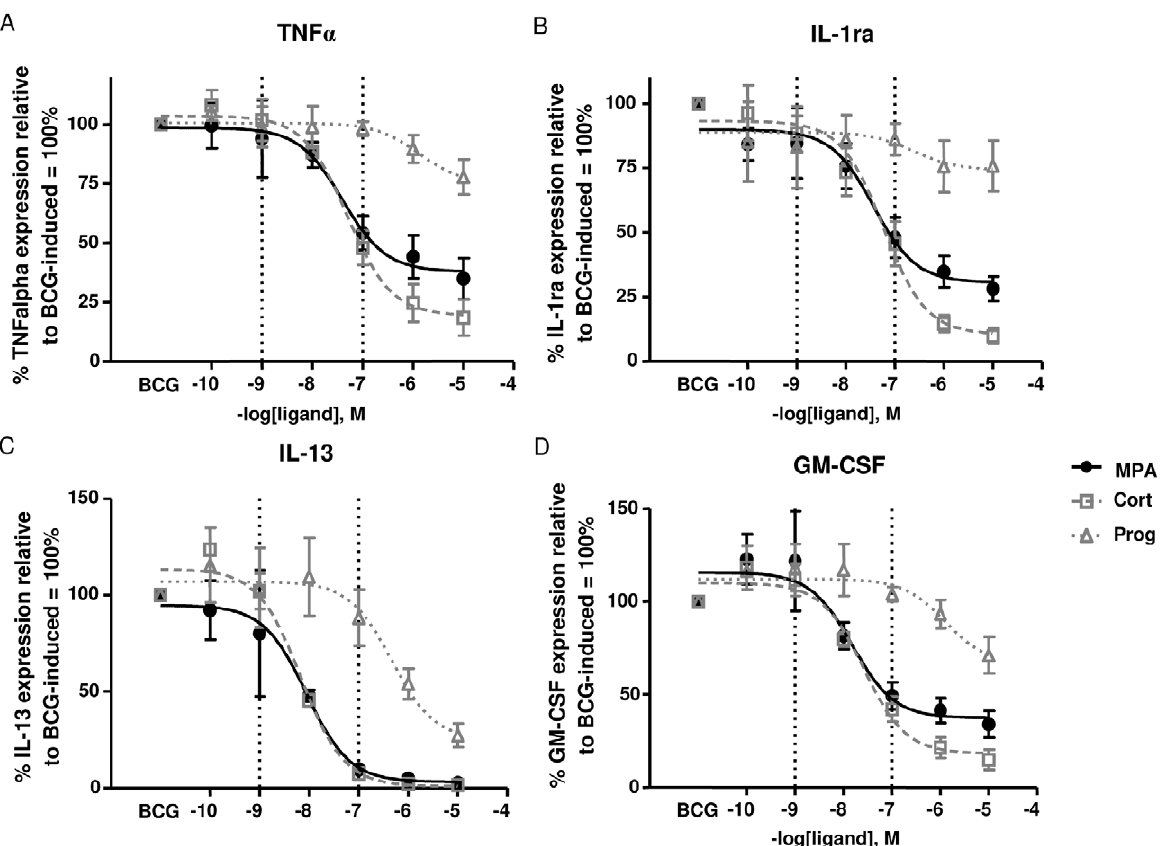
Figure 3. Dose-response curves of cortisol, MPA and progesterone on BCG-induced cytokine expression. Culture supernatants of PBMCs stimulated with a concentration of 5 6 10 5 CFU/ml BCG in the absence and presence of the three hormones were collected six days post stimulation (n=4). TNF a , IL-1ra, IL-13 and GM-CSF (A-D) levels were measured using a Multiplex bead array assay. Hormone stimulated responses are depicted as percentages of the BCG only (100%) responses. Dotted lines indicate the range of MPA serum concentrations measured in contraceptive users. Dose-response curves were generated using GraphPad Prism 5 (nonlinear regression curve) and data are presented as mean 6 SEM. Data of four study participants were analyzed to obtain IC 50 and EC 50 values.